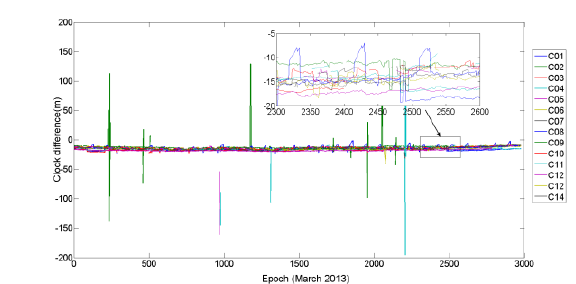
Figure 1 Difference between broadcast clock and precise clock